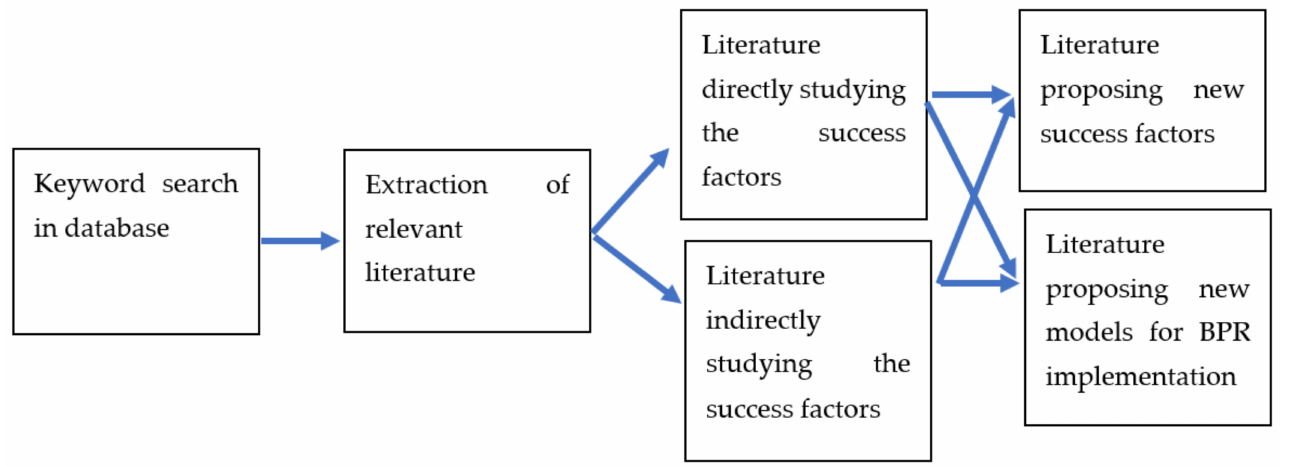
Figure 1. Methodology used for the literature